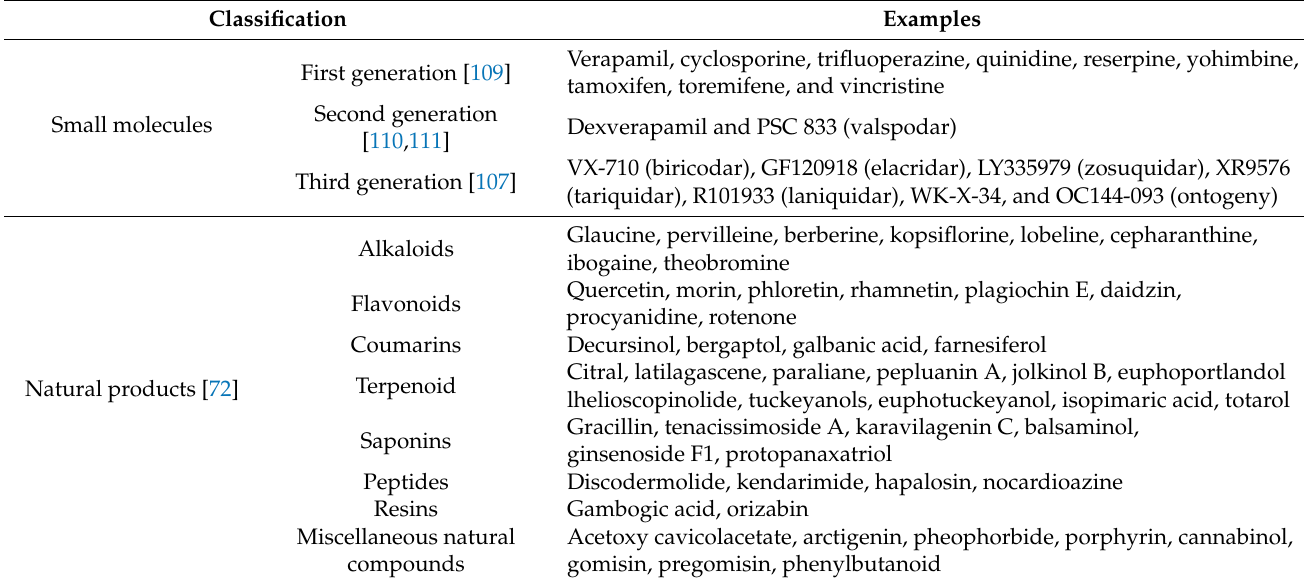
Table 1. Classification of P-glycoprotein